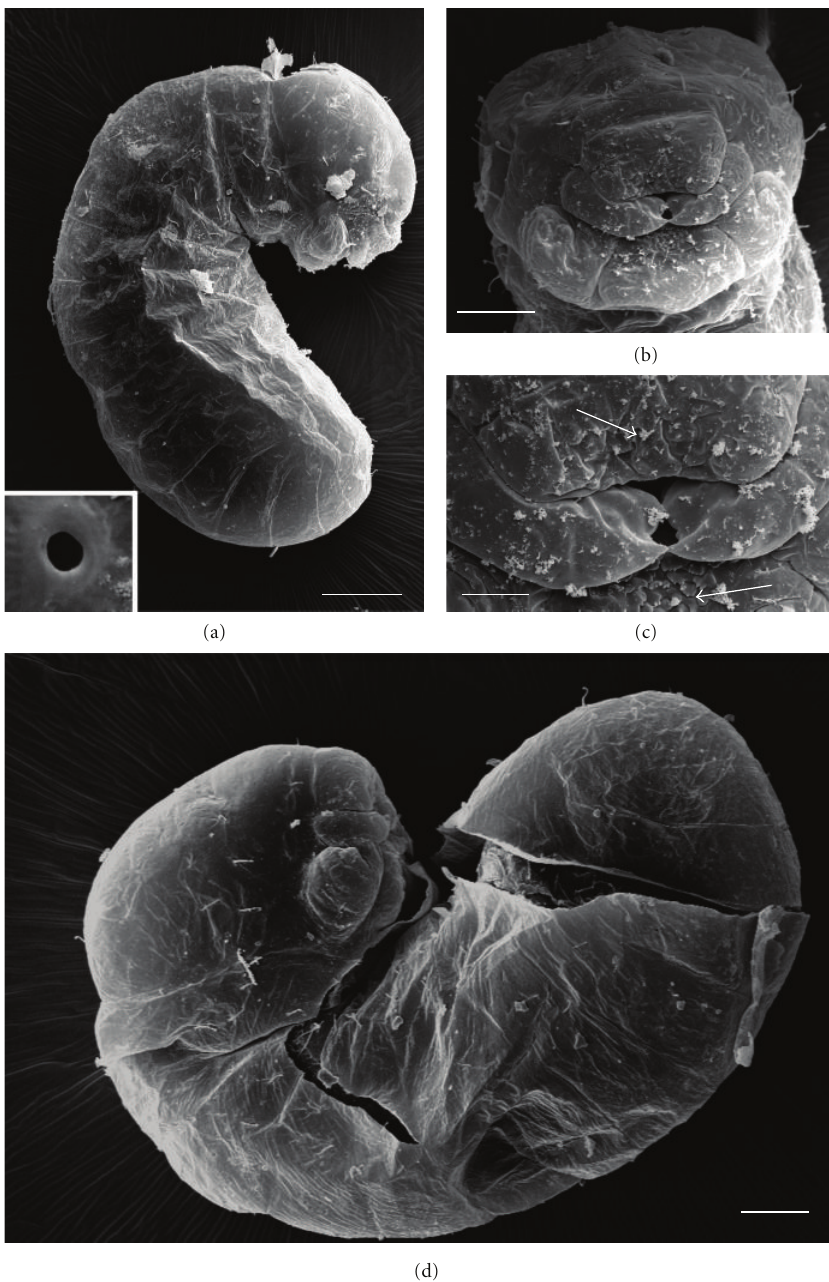
Figure 2: Second instar larva of Solenopsis saevissima . (a) Larva on side view; inset: thoracic spiracle. (b) Head capsule. (c) Mouthparts; arrows: spines around mouth entrance. (d) Larva moulting to third instar. Respective sizes of scale bars ( µ m): 100, 40, 15, and 50.